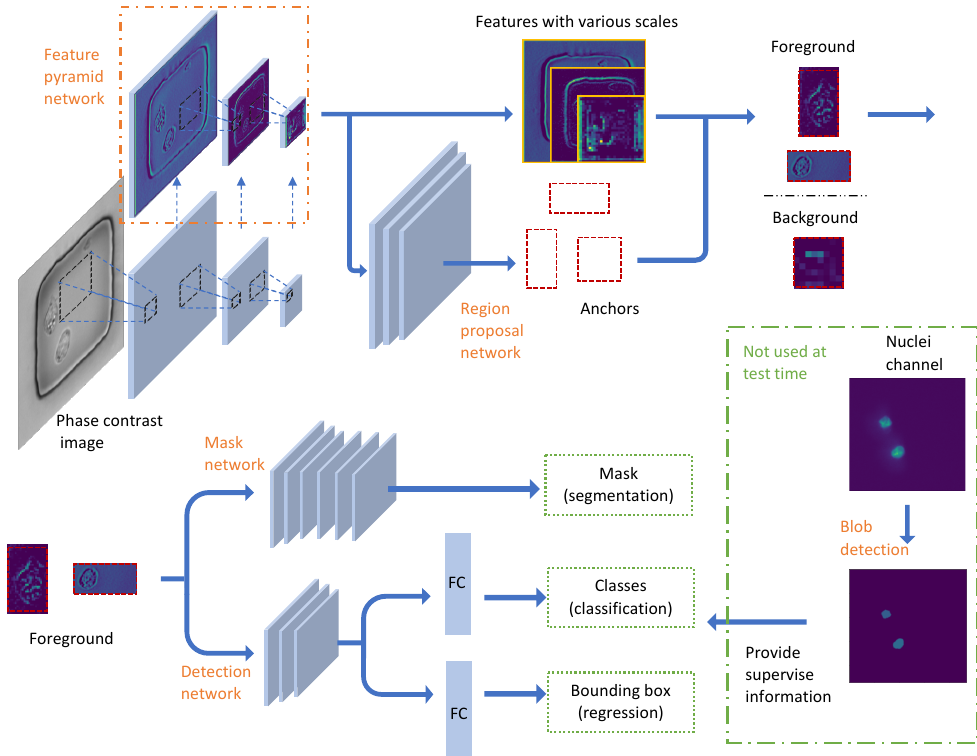
Figure 2. The workflow of instance nuclei detection and segmentation. There are five modules: Blob detection, Feature pyramid network, Region proposal network, Detection network and Mask network. Note that blob detection is only utilized for training and is not needed during